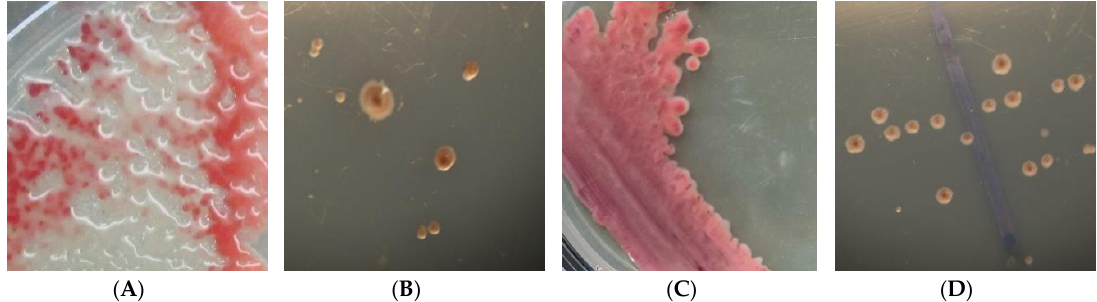
Figure 2. Colony morphology of converted fluidal strain before and after gfp labeling: ( A ) colonies before gfp labeling in Petri plate, ( B ) single colony morphology in stereo microscope before gfp labeling, ( C ) colonies after gfp labeling in Petri plate, and ( D ) single colony morphology in stereo microscope after gfp labeling.